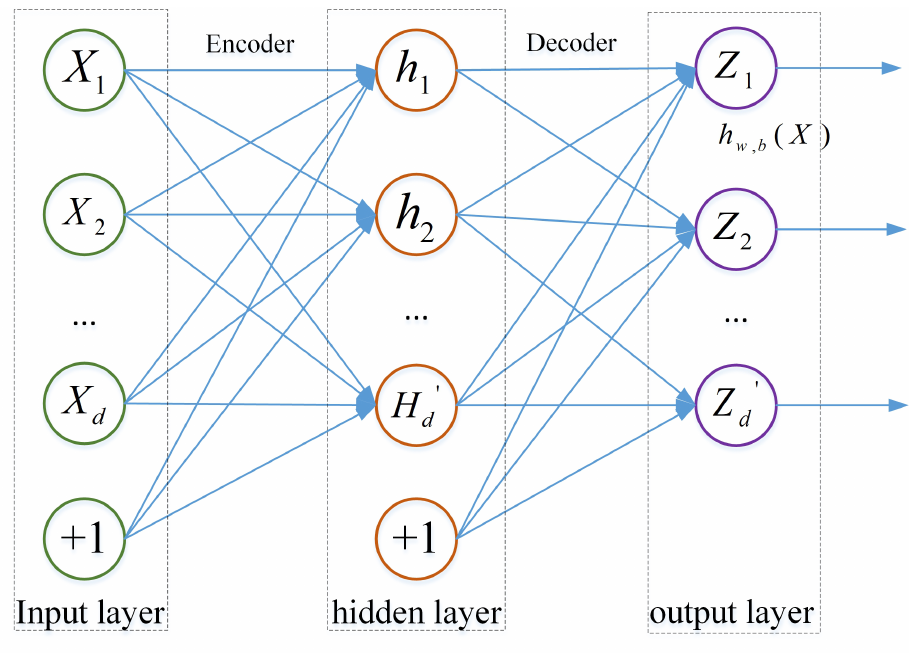
Figure 1. Simplified network structure of autoencoder